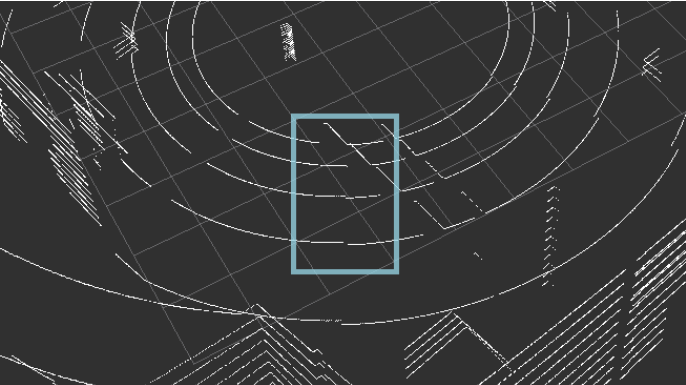
Figure 3. A slight effect of the rolling shutter effect observed in the point cloud obtained from an actual device (Velodyne VLP-16) driving around the